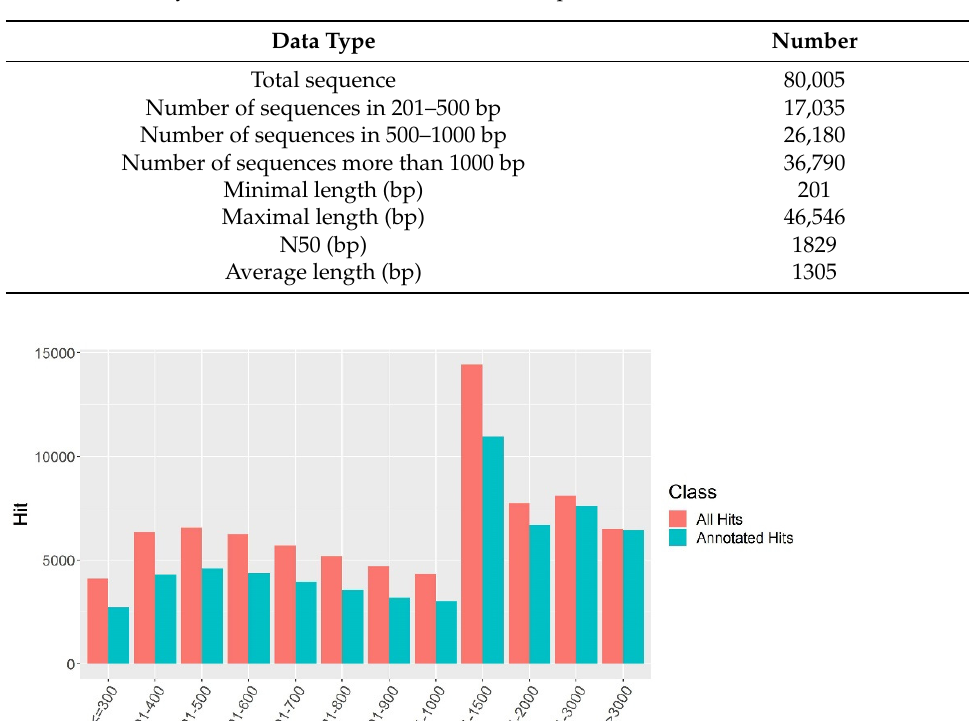
Table 1. Summary of de novo assembled alfalfa transcriptome.